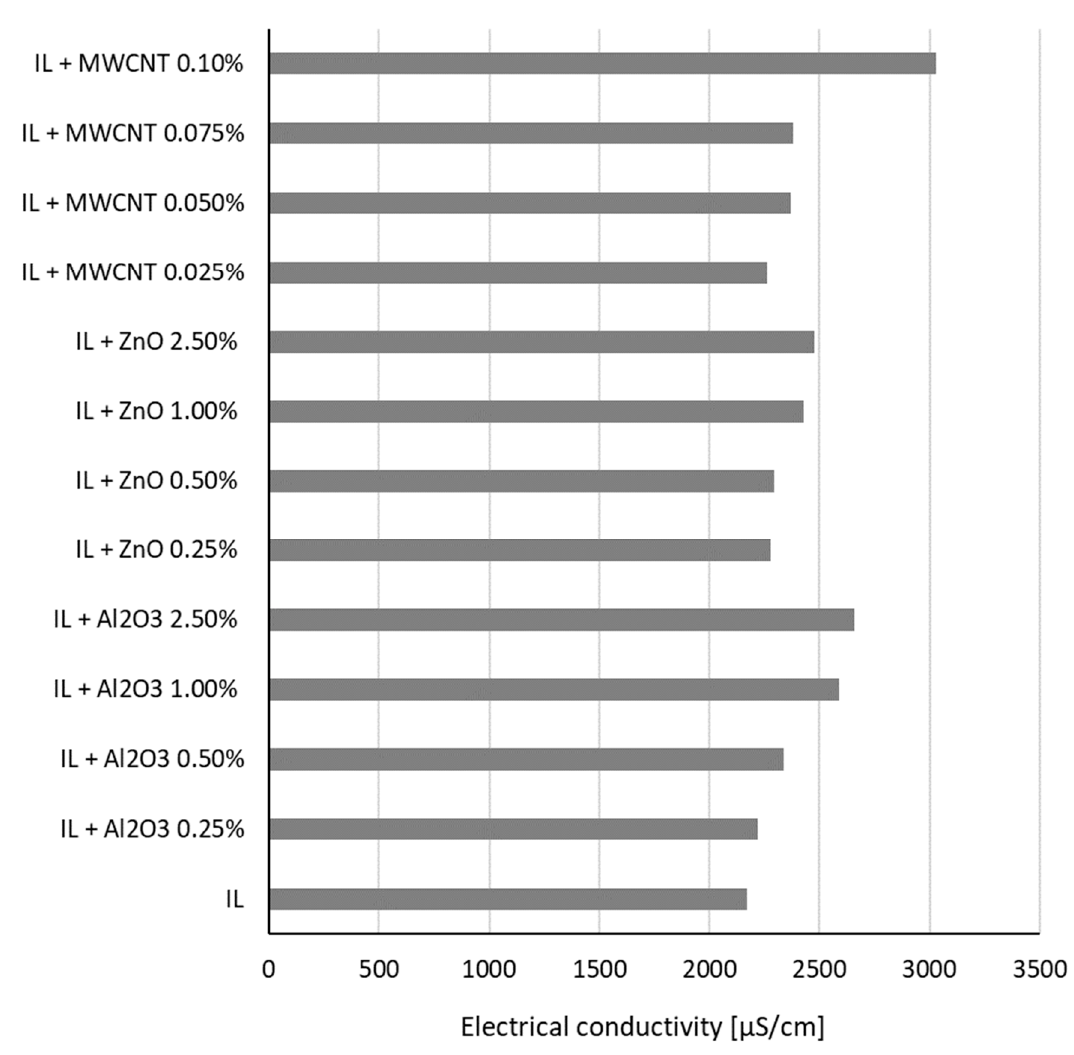
Figure 1. Experimental data of all samples at ambient temperature.